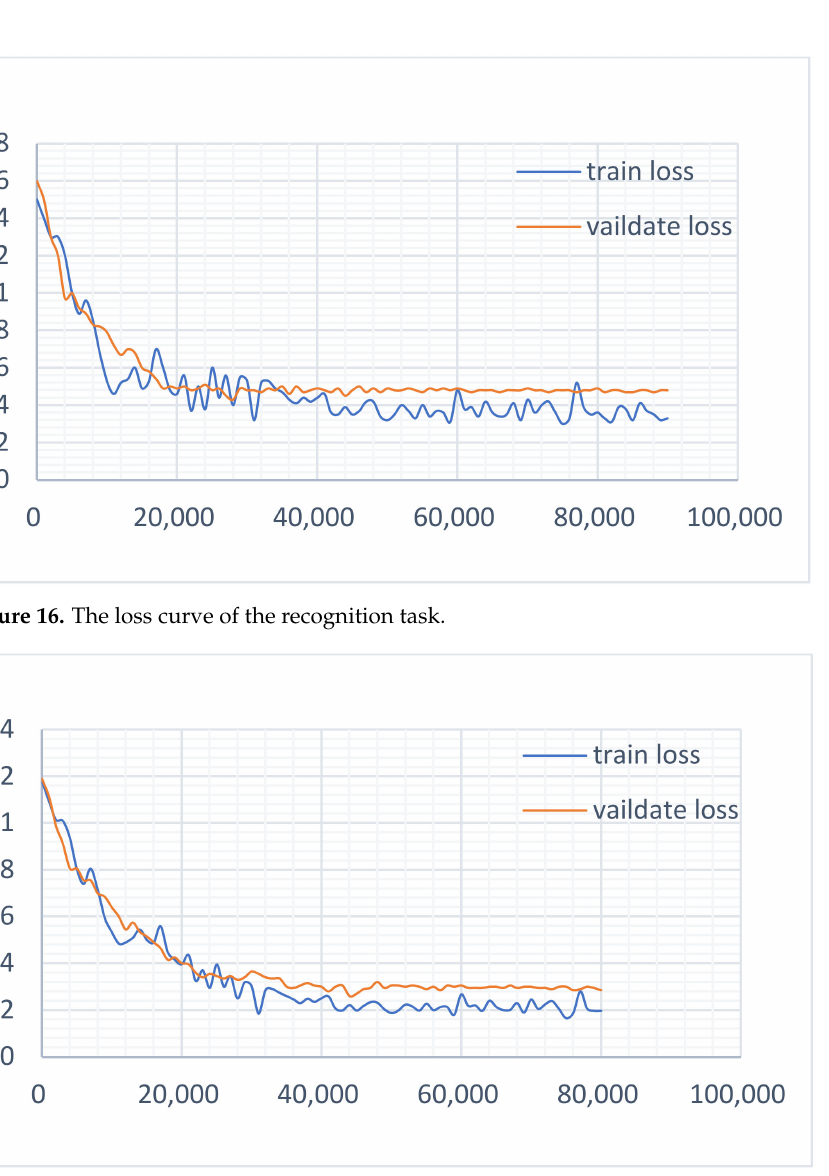
Figure 17. The loss curve of the multi-task learning